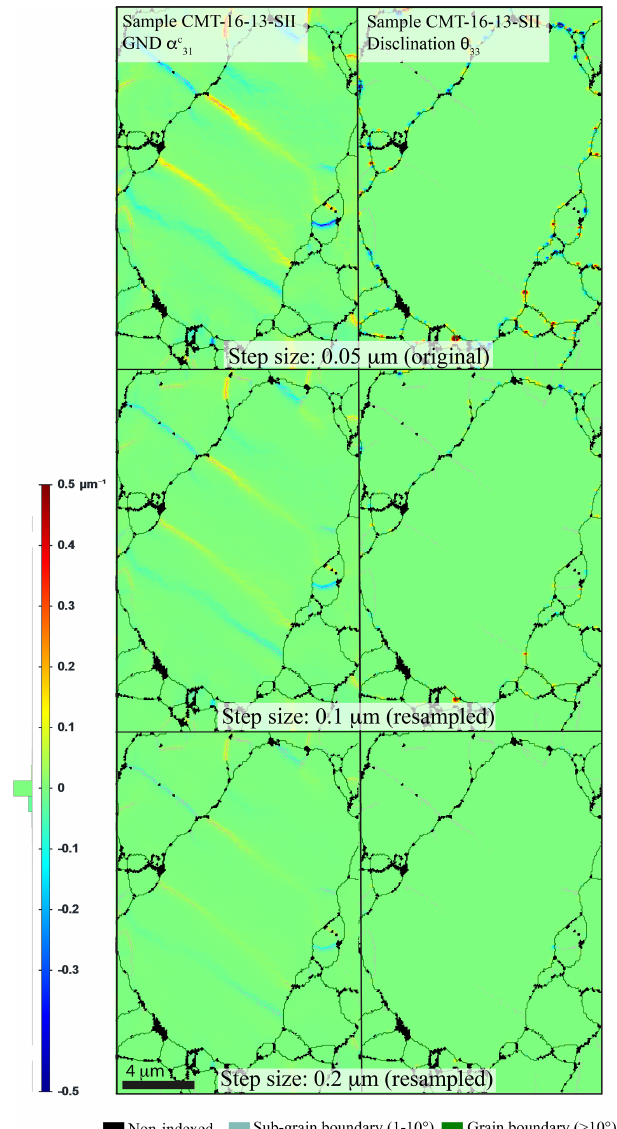
Figure 8. Representative distribution of GND ( α c ) and disclina- 31 tions ( θ 33 ) for the following values of step size in a sample de- formed in axial compression (CMT-16-13-SII, 1200 ◦ C, low strain ∼ 3.7%) centered on a large olivine grain: 0.05µm (original step size), 0.1µm (new sampling), and 0.2µm (new sampling). The den- sity scale is user-defined and the same for this set of maps; for both GND and disclinations the smoothing factor was 2.